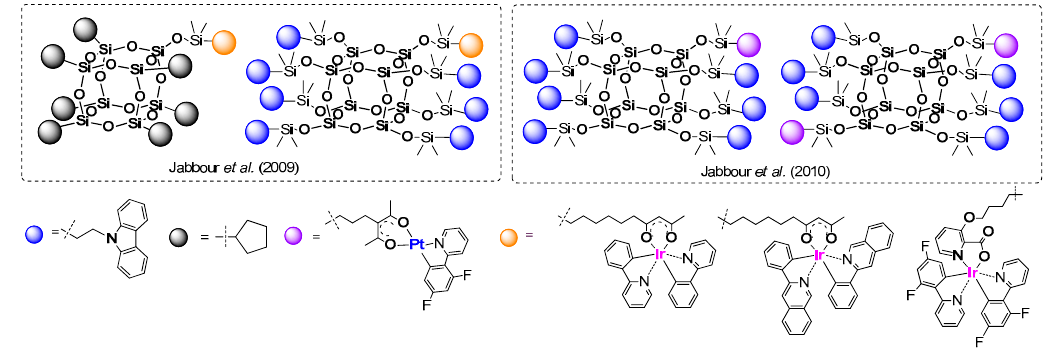
Figure 33. The POSS-based complexes of Ir and Pt obtained by hydrosilylation.